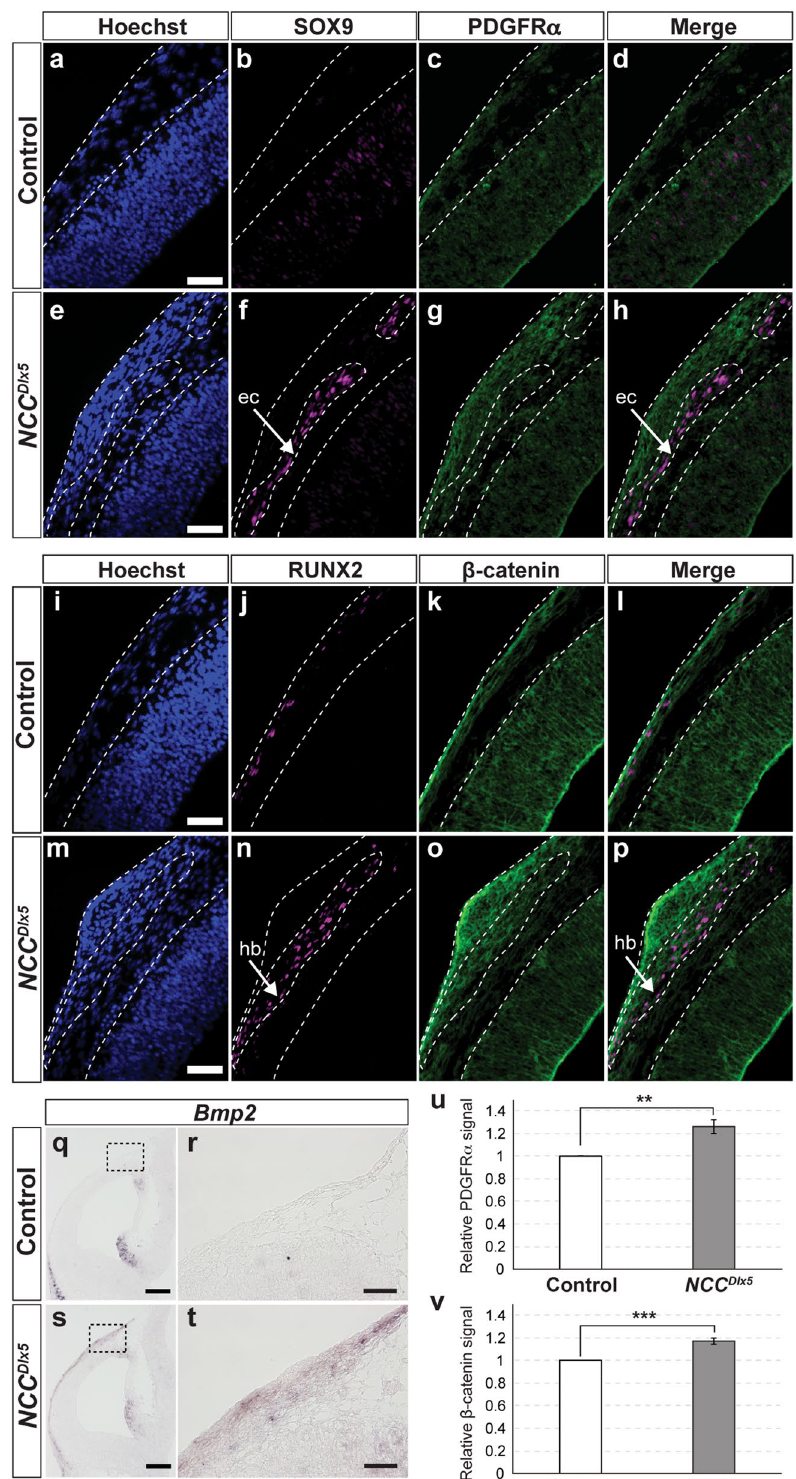
Figure 7. PDGFRα, β-catenin and Bmp2 signals in the EMM at E11.5. ( a – h ) Double immunofluorescent staining for SOX9 and PDGFRα on frontal sections at E11.5, nuclear counterstained by Hoechst of the control ( a – d ) and the NCC Dlx5 ( e – h ). Arrows in f , h point to the ectopic cartilage. PDGFRα signal is shown in the SOX9-positive area ( h ). ( i – p ) Double immunofluorescent staining for RUNX2 and β-catenin on frontal sections at E11.5, nuclear counterstained by Hoechst of the control ( i – l ) and the NCC Dlx5 ( m – p ). Arrows in ( n , p ) point to the heterotopic bone. β-catenin signal is shown in the RUNX2- positive area ( p ). ( q – t ) Bmp2 expression by ISH on frontal sections at E11.5 of the control ( q , r ) and the NCC Dlx5 ( s , t ). ( r , t ) are high magnified images of the boxed area in ( q , s ). ( u , v ) Semi-quantification analysis on immunofluorescent staining for PDGFRα and β-catenin. Two-tailed t-test;** p < 0.01;*** p < 0.001. ec, ectopic cartilage; hb, heterotopic bone. Scale bars; 50 μm ( a , e , i , m , r , t ); 200 μm ( q , s